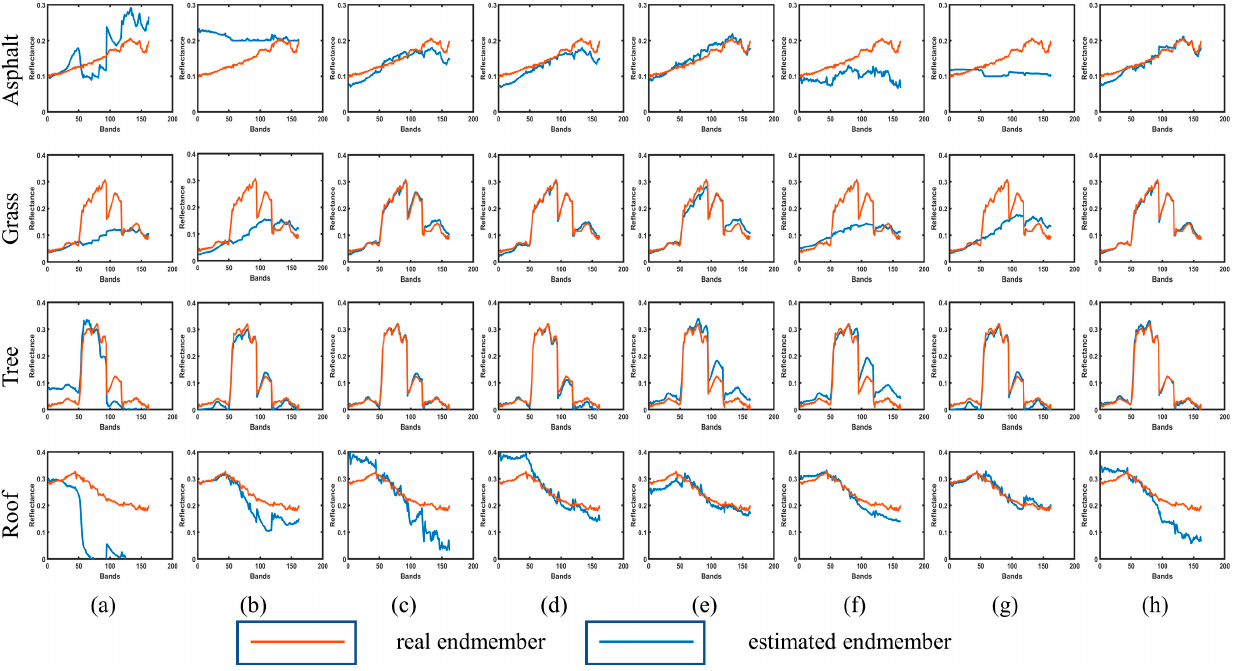
Figure 18. Visualization results of the endmembers of Urban data. ( a ) VCA-FCLS. ( b ) SGCNMF. ( c ) DAEU. ( d ) MTAEU. ( e ) CNNAEU. ( f ) CyCU-Net. ( g ) MiSiCNet. ( h ) SSANet. ( c ) DAEU. ( d ) MTAEU. ( e ) CNNAEU. ( f ) CyCU-Net. ( g ) MiSiCNet. ( h )